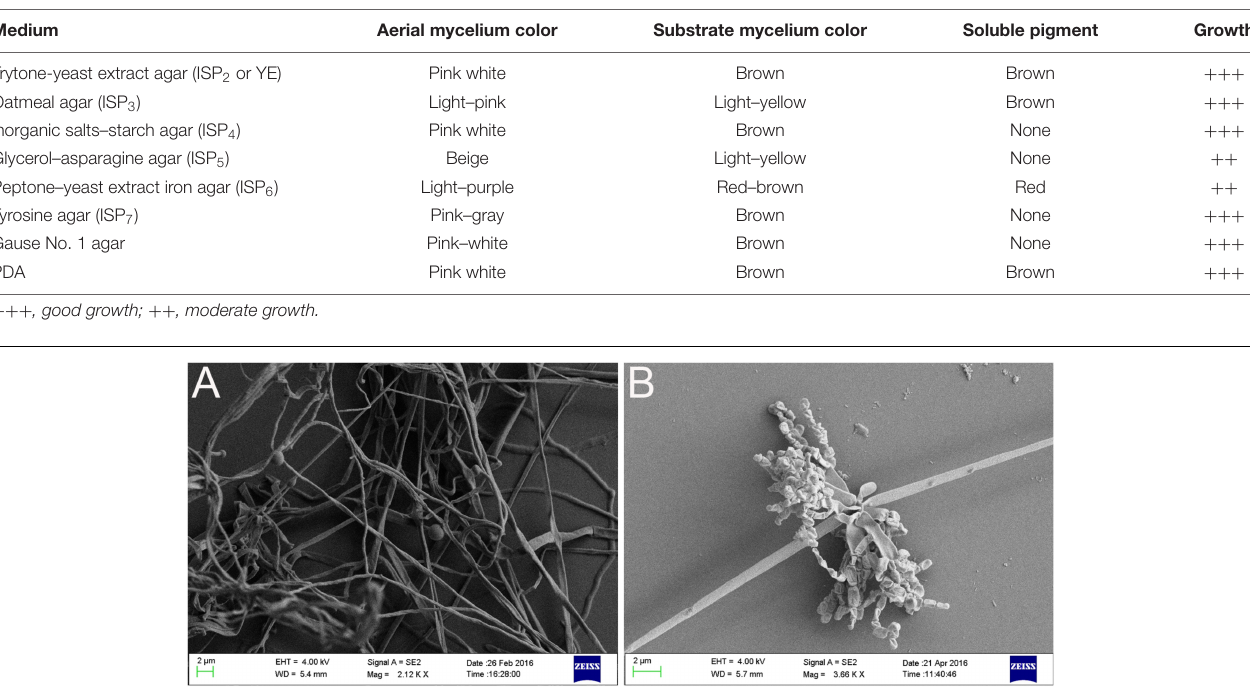
TABLE 1 | Cultural characteristics of strain SCA3-4.